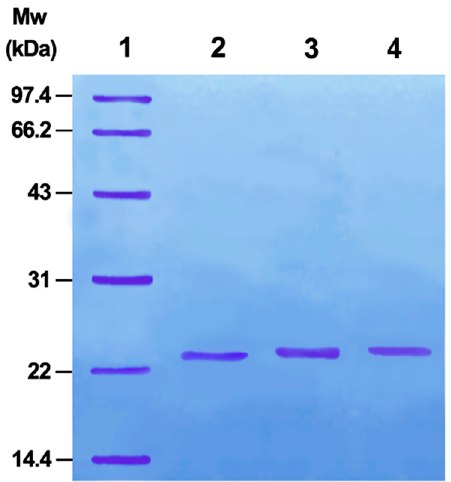
Figure 1. Discontinuous SDS-PAGE analysis of mimics. ( 1 ) Marker proteins; ( 2 ) TSeO 2 H; ( 3 ) TSeSG; ( 4 ) ITSeSG. SDS-PAGE was performed on a Pharmacia gel system following standard procedures.